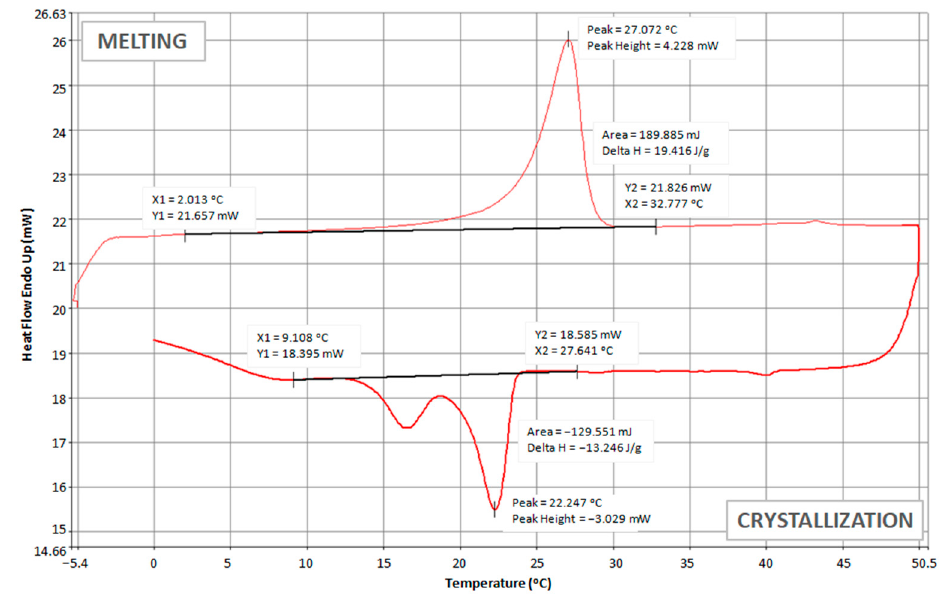
Figure 6. DCS thermogram of PES + A2_10 + PCM2_7.5 insert.